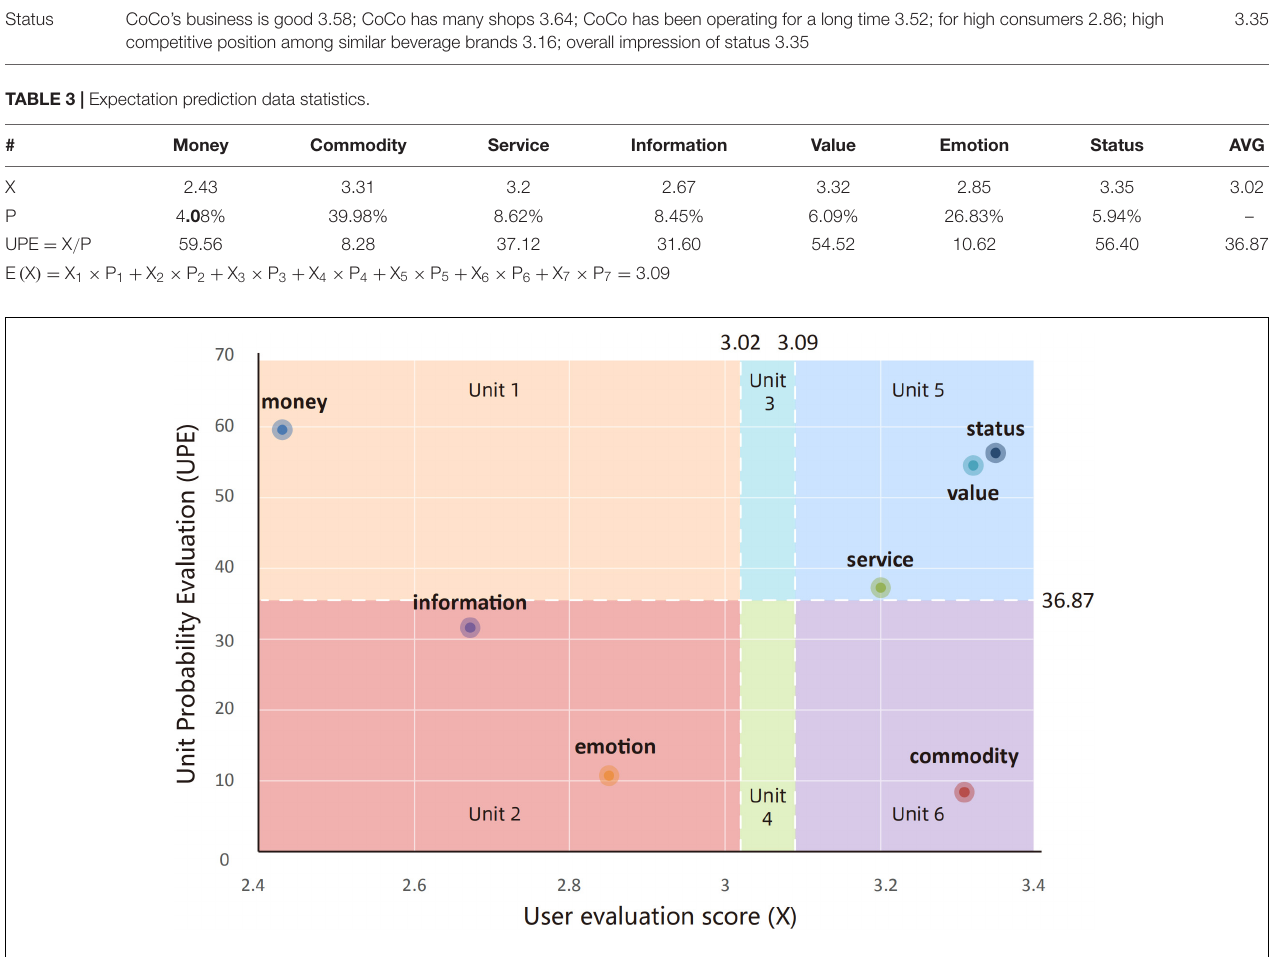
FIGURE 10 | Expectation prediction interval graph of CoCo Fresh Tea &